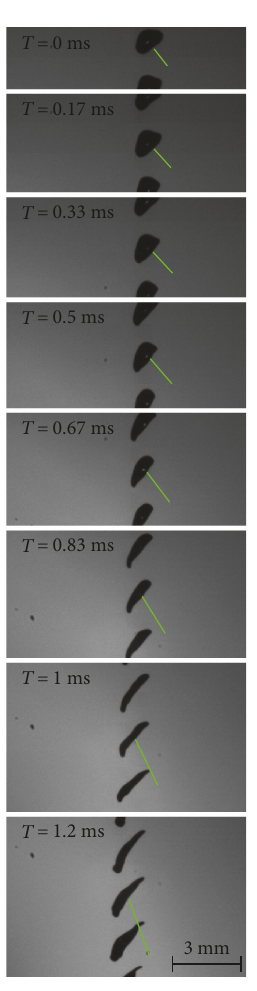
Figure 15: Direction of the slip velocity, computed from the experimental results, superimposed on the droplet ’ s train corresponding to case #9.